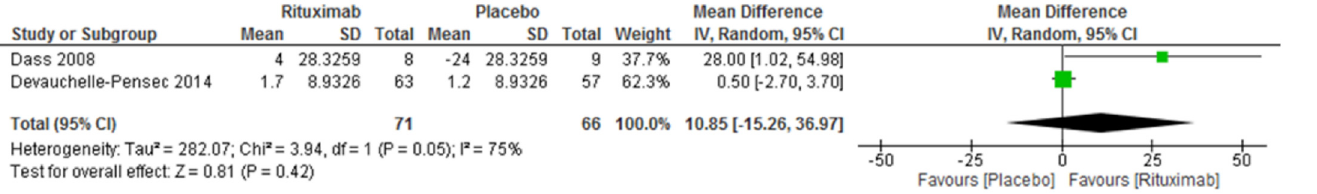
Fig 7. Rituximab X Placebo. Meta-analysis of the outcome SF-36 mental component summary at week